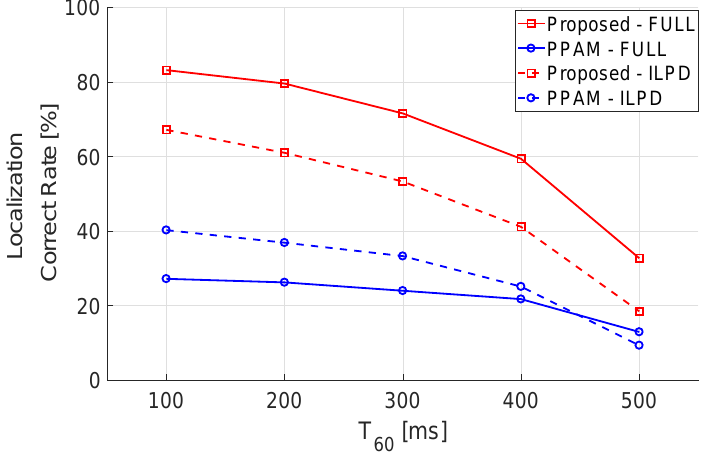
Figure 9. Comparing the localization accuracy between proposed method and PPAM with different T 60 . The angular error tolerance is 2.5 ◦ .